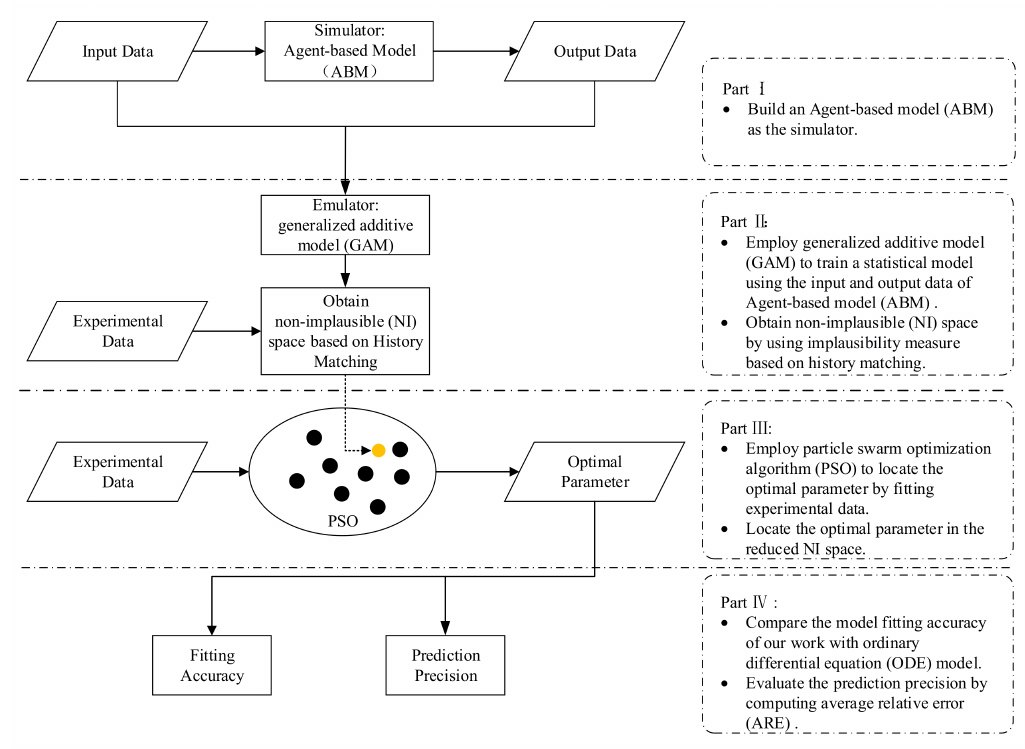
Figure 1. Procedure route.